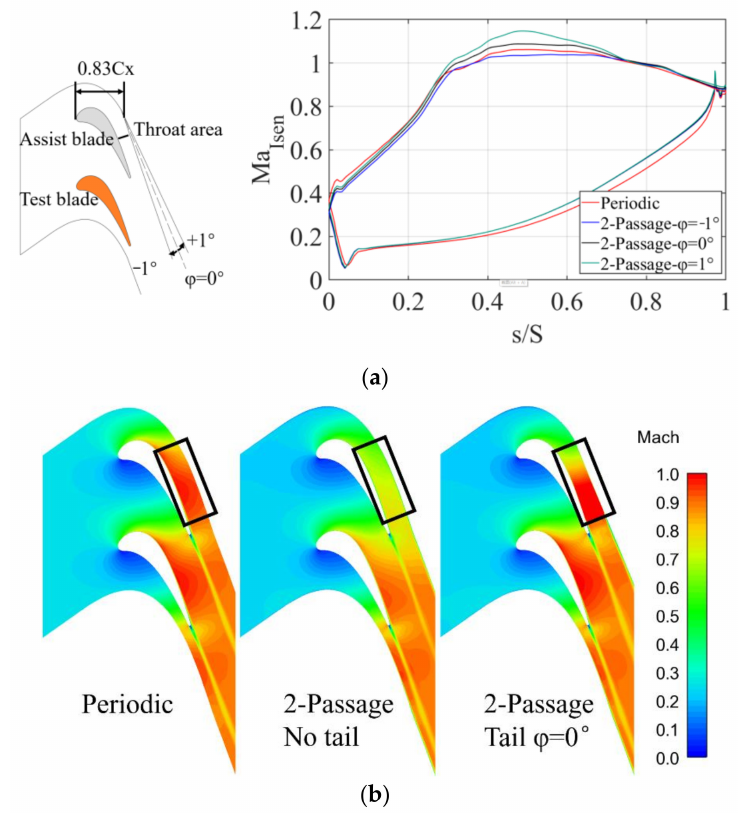
Figure 6. Tailboard adjustment, ( a ) near tip isentropic Mach number distribution of test blade surface for Periodic and three tailboard angles ( − 1 ◦ , 0 ◦ , +1 ◦ ) cases, ( b ) Mach number distribution for Periodic, 2-Passage and 2-Passage 0 ◦ tailboard cases.